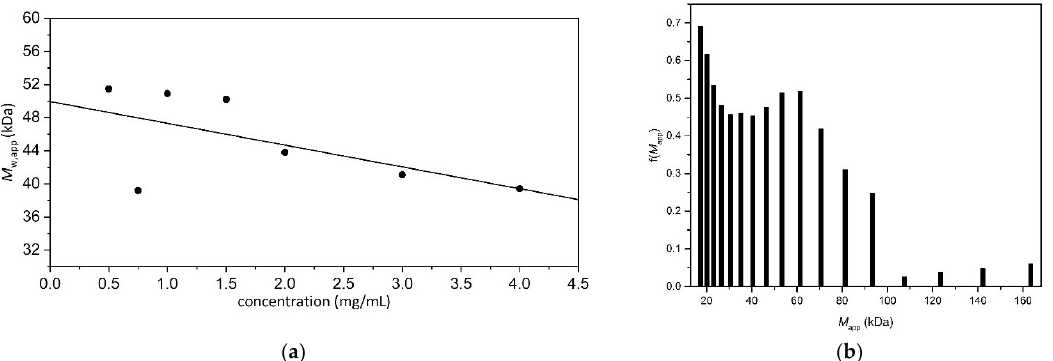
Figure 5. Sedimentation equilibrium of Butvar B-98 in isopropanol. Rotor speed 22,000 rpm. Tem- perature = 20.0 °C. ( a ) Dependence of the apparent M w,app on concentration, with an extrapolation to obtain the thermodynamically ideal M w of Butvar B-98 = (54.0 ± 1.5) kDa. The data was analysed with SEDFIT-MSTAR using the M * method. ( b ) Estimation using MULTISIG of the molar mass